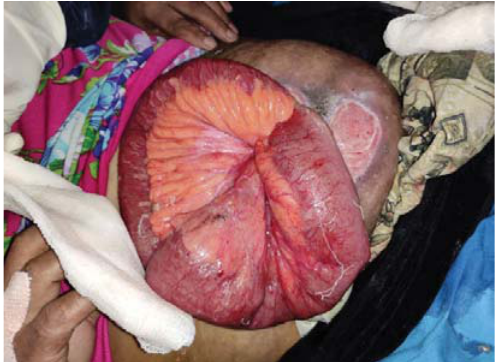
Figure 1. Ruptured umbilical hernia with protruded bowel (Patient’s head end towards the top of the image) Journal of Society of Surgeons of Nepal J Soc Surg Nep. 2020; 23(2)